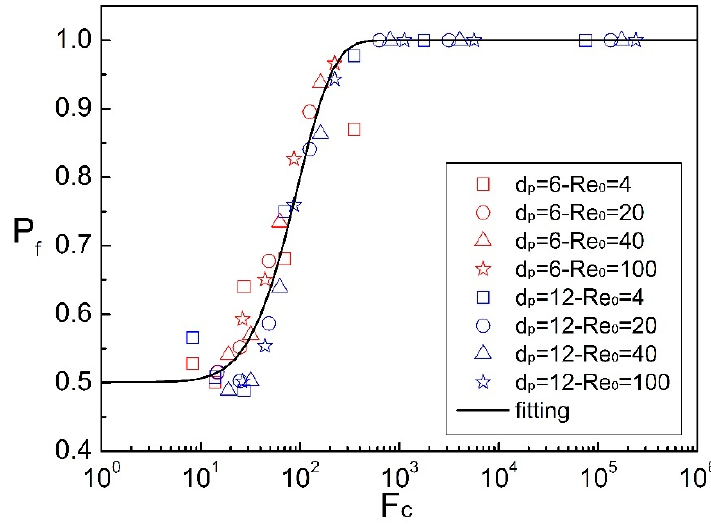
Figure 17. The degree of inertial migration as a function of the focusing number. The data was originally reported in [37].